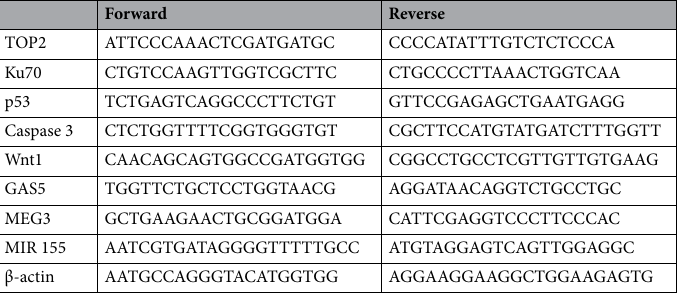
Table 1. Sequences of human